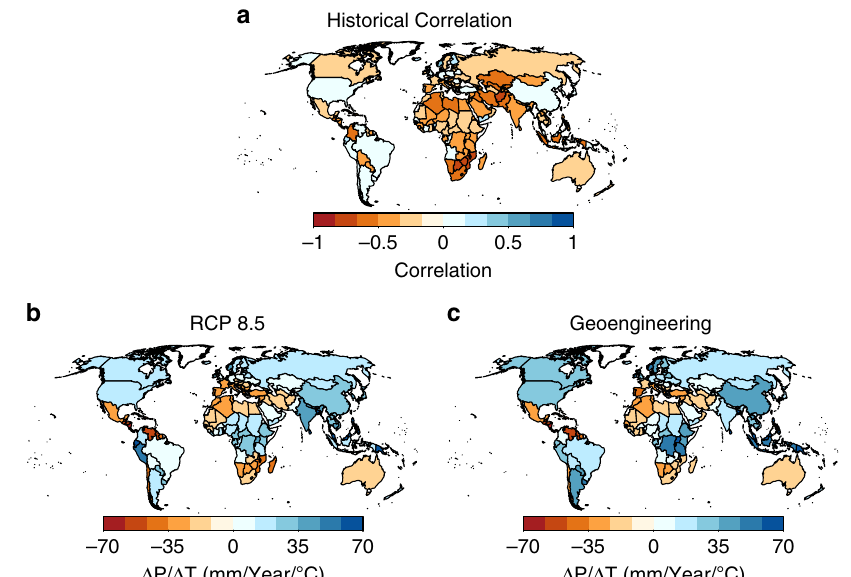
Fig. 5 Historical and projected relationship between surface temperature and annual precipitation. a Historical correlation between temperature and precipitation. Change in precipitation relative to change in temperature projected by ( b ) a CMIP5 ensemble for RCP8.5 and by ( c ) a GeoMIP ensemble for solar geoengineering to reduce the global the mean temperature by an equal amount as the warming under RCP8.5. The sign of the projected relationship between precipitation and temperature changes for 76 of 165 countries under RCP8.5 and 73 of 165 countries under solar